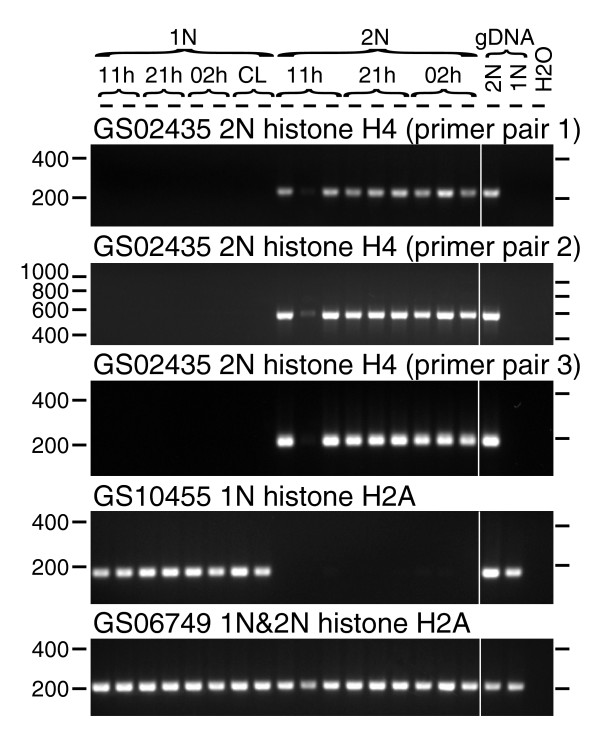
RT-PCR determination of expression patterns of selected histone genes. Positions of molecular weight markers on each side of the gel are shown. The sample identifiers are listed for each lane at the top of the gel (as for Figure 7).